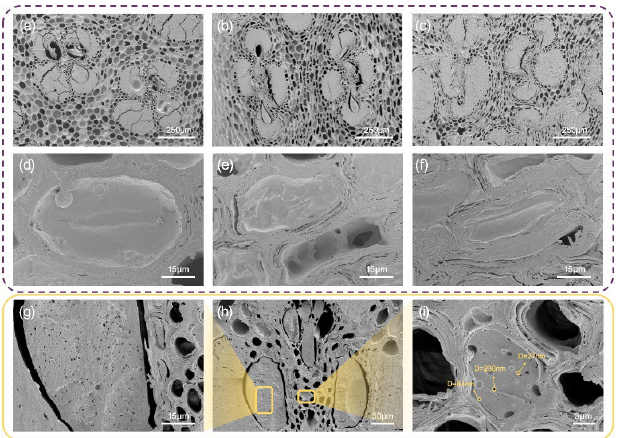
Figure 5. SEM micrographs of BSC-20-1.0 ( a , d ), BSC-20-1.15 ( b , e ), BSC-20-1.3 ( c , f ), and cured PF resin ( g – i ). Note: D denotes the diameter of the pore.